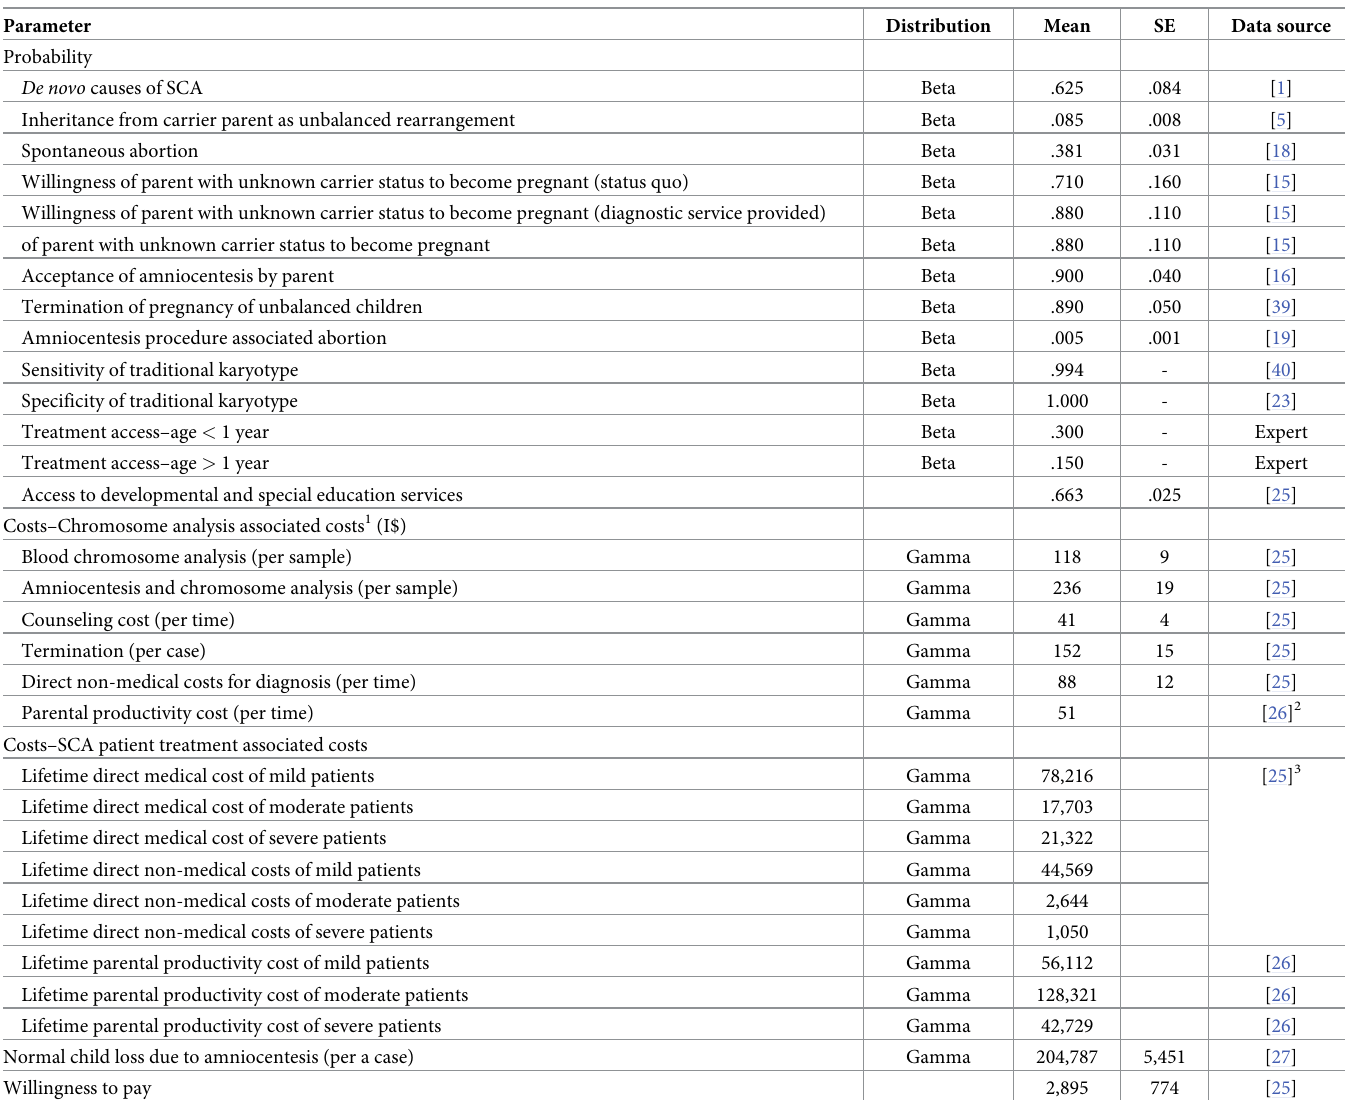
Table 2. Means and standard errors (SE) of input